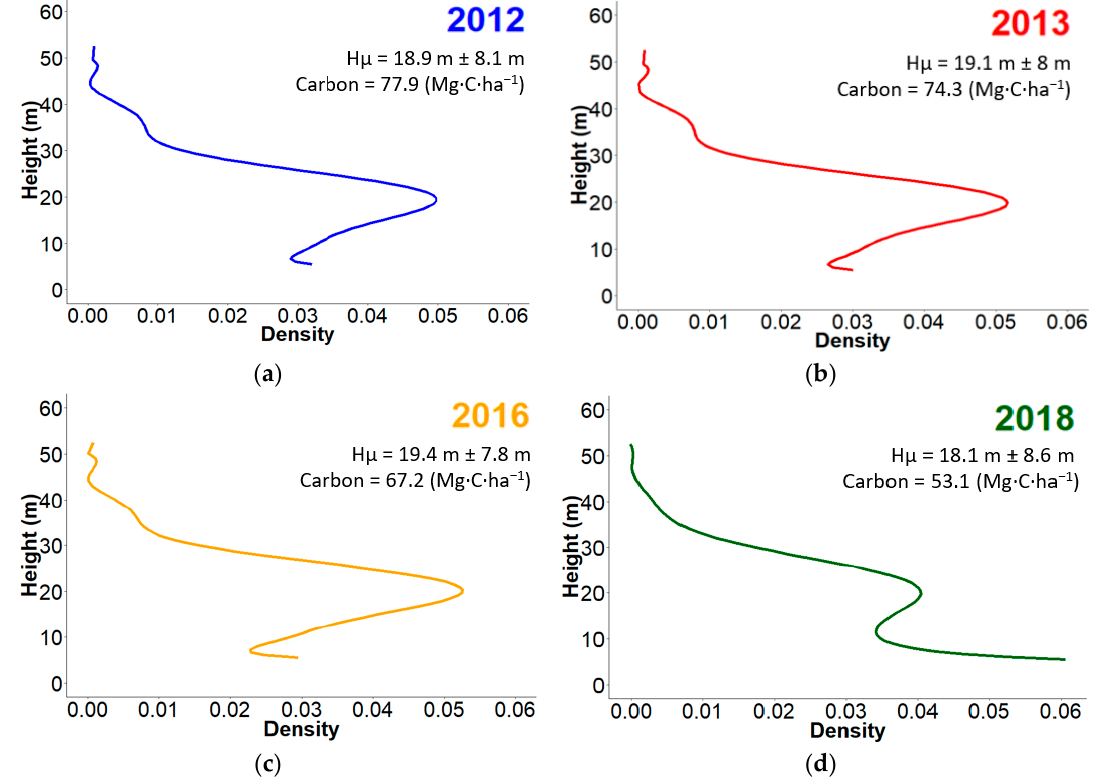
Figure 2. Vertical distribution of canopy elements derived from LiDAR CHM for ( a ) 2012, ( b ) 2013, ( c ) 2016, and ( d ) 2018. Mean canopy height and standard deviation are shown for each year, as well as the Aboveground Carbon Density (ACD).